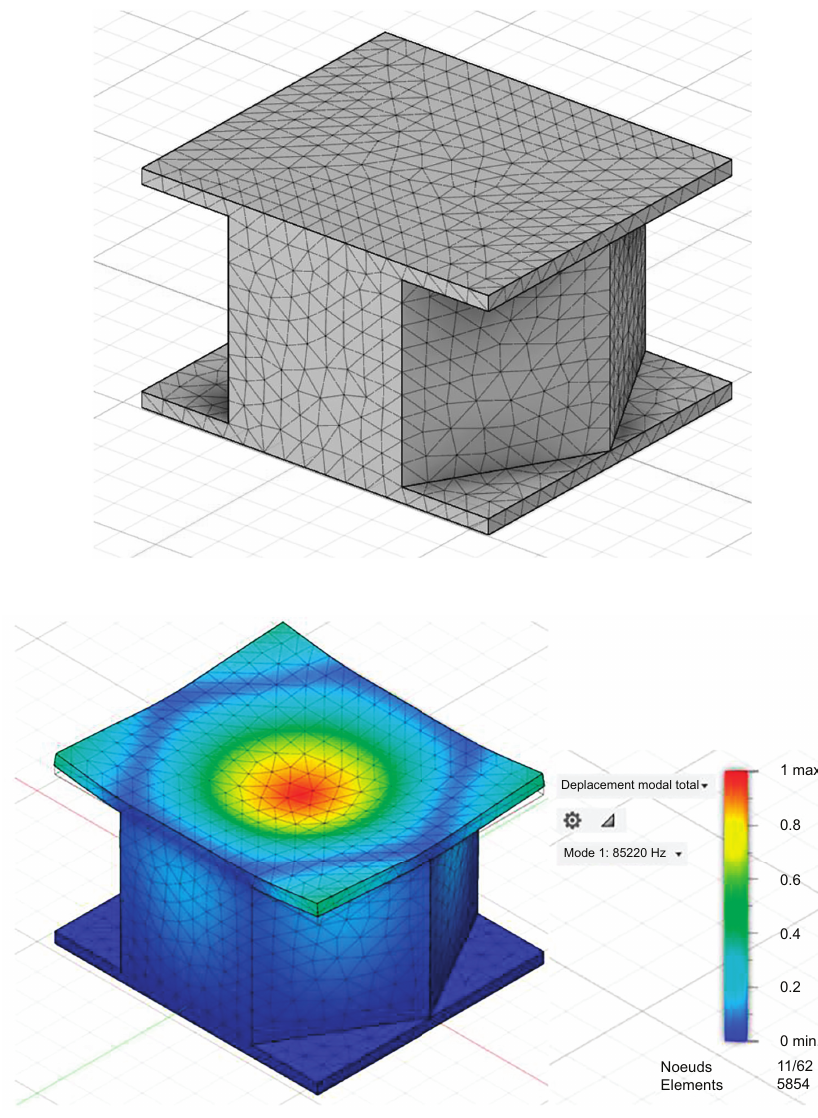
Figure 7. Vibration analysis of the unit